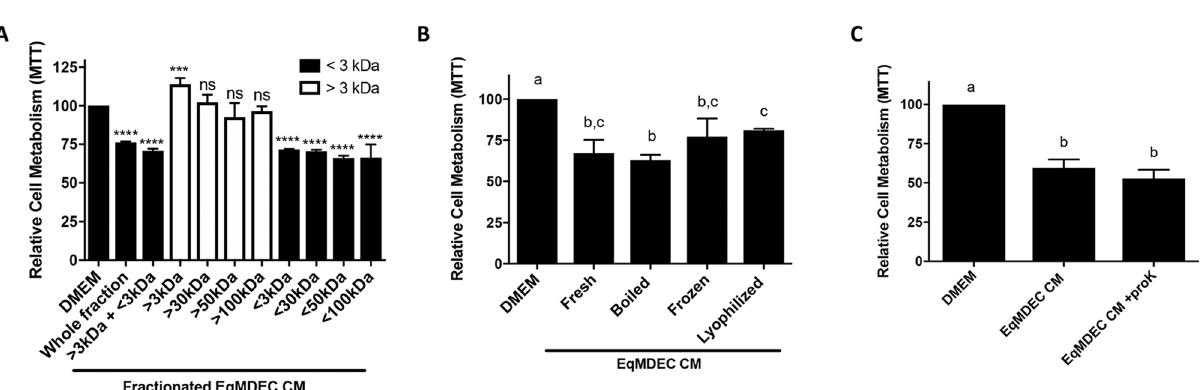
Figure 3. The bioactive factor(s) in EqMDEC CM are small in size and temperature-stable. MTT assays of MDA-MB-231 cultured for 48 h in the presence of EqMDEC CM that was manipulated, as described. DMEM controls were also included for each experiment. ( A ) EqMDEC CM was fractionated with centrifugation filters. ( B ) EqMDEC CM was either boiled at 100 °C for 10 min, frozen at − 80 °C for one week, or lyophilized and reconstituted to its original volume. ( C ) EqMDEC CM was pre-treated with proteinase K. Significant differences are either depicted by asterisks: ****p < 0.0001, or by different letters. ns: not significant, n = 3. Data are presented as the mean ± standard